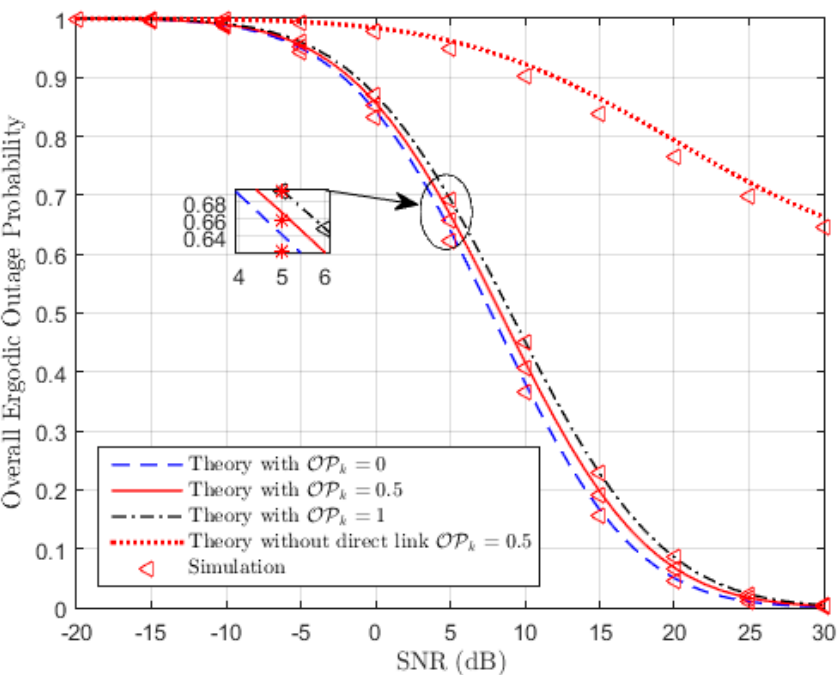
Figure 5. Relation between the overall ergodic OP and the SNR, with three OP k values.